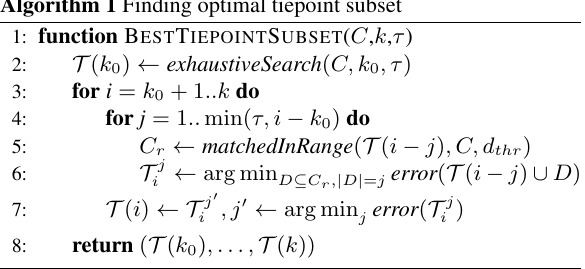
Algorithm 1 Finding optimal tiepoint